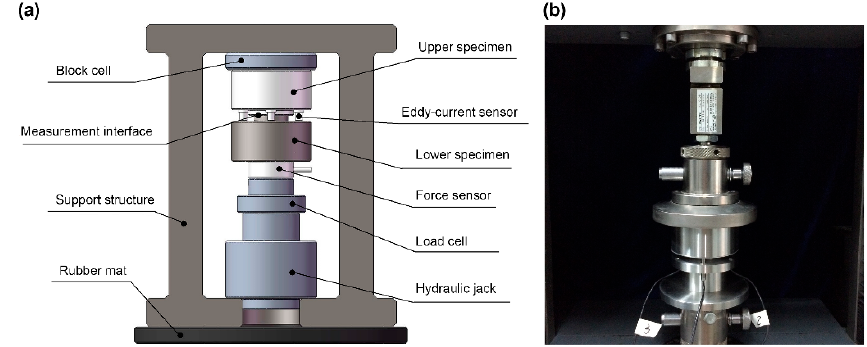
Figure 5. ( a ) A schematic diagram of the contact sti ff ness test rig. ( b ) Physical drawings of the contact sti ff ness test